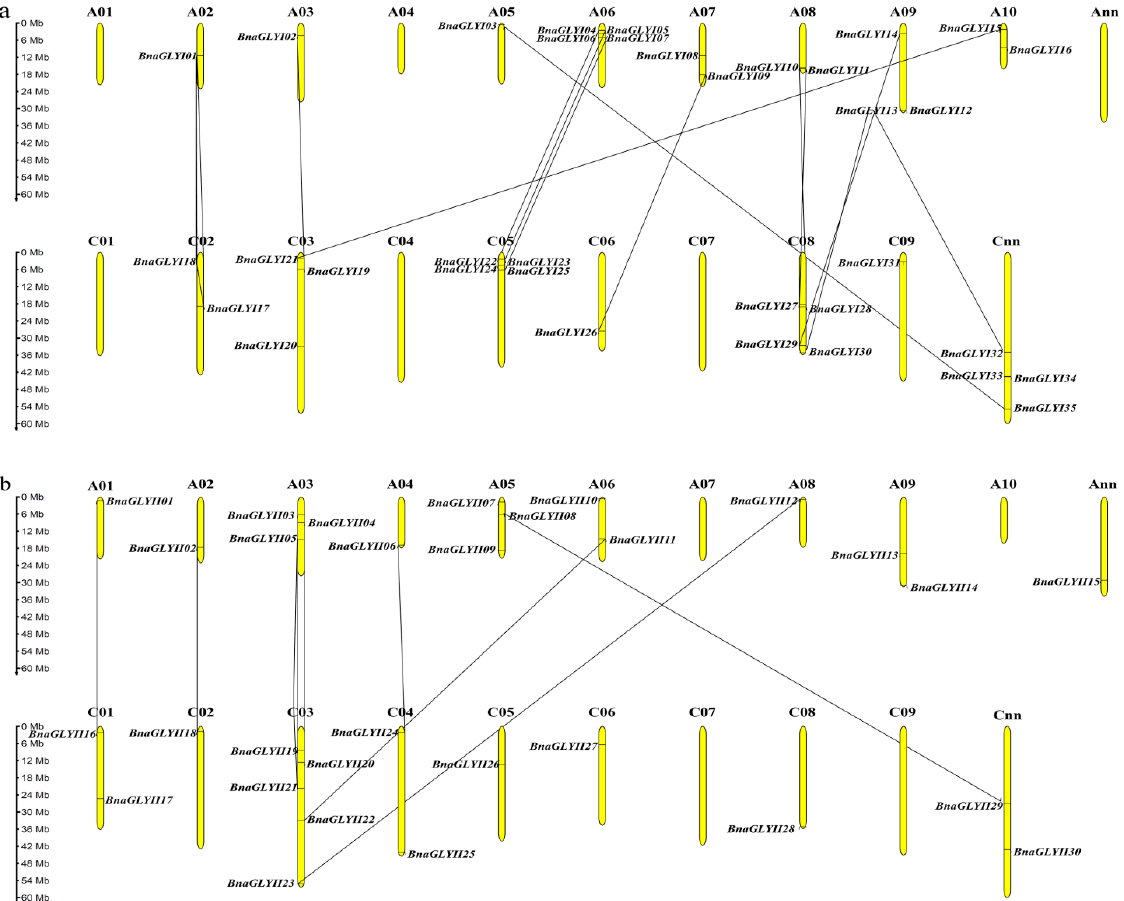
Figure 1. Chromosomal localization of BnaGLYI ( a ) and BnaGLYII ( b ) genes in the B. napus chromo- somes. Duplicated genes are connected by black lines.